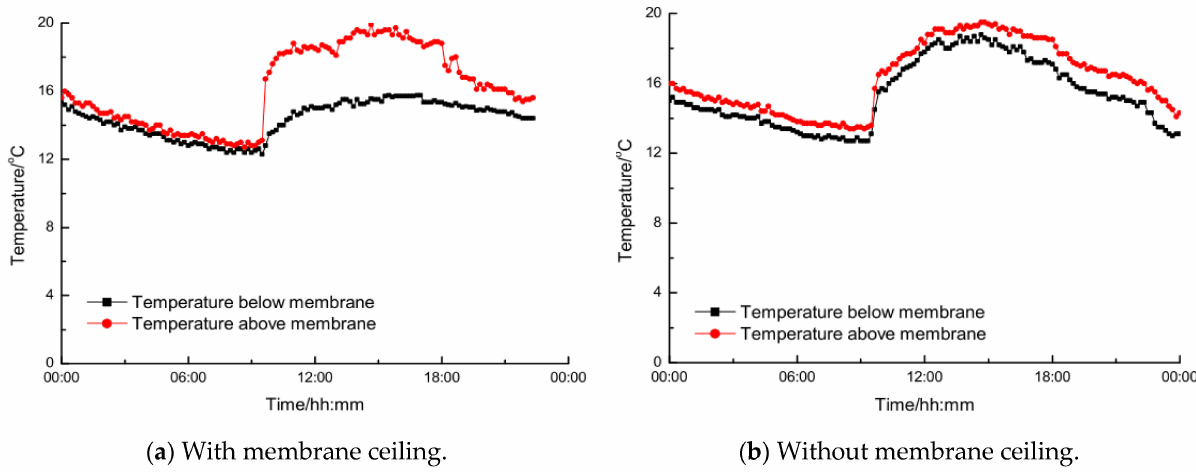
Figure 19. Temperature fluctuating with time